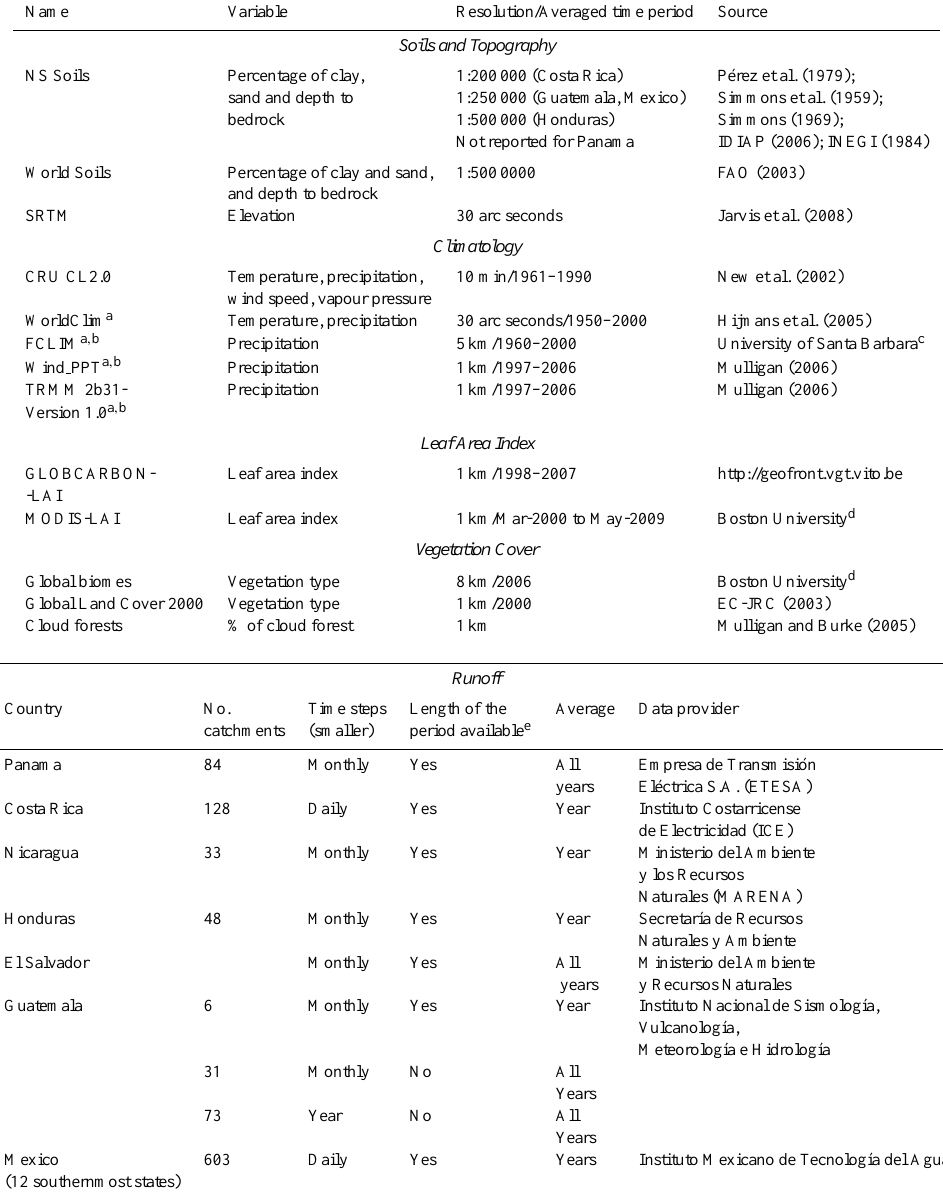
Table 1. Data sources for model input, calibration and